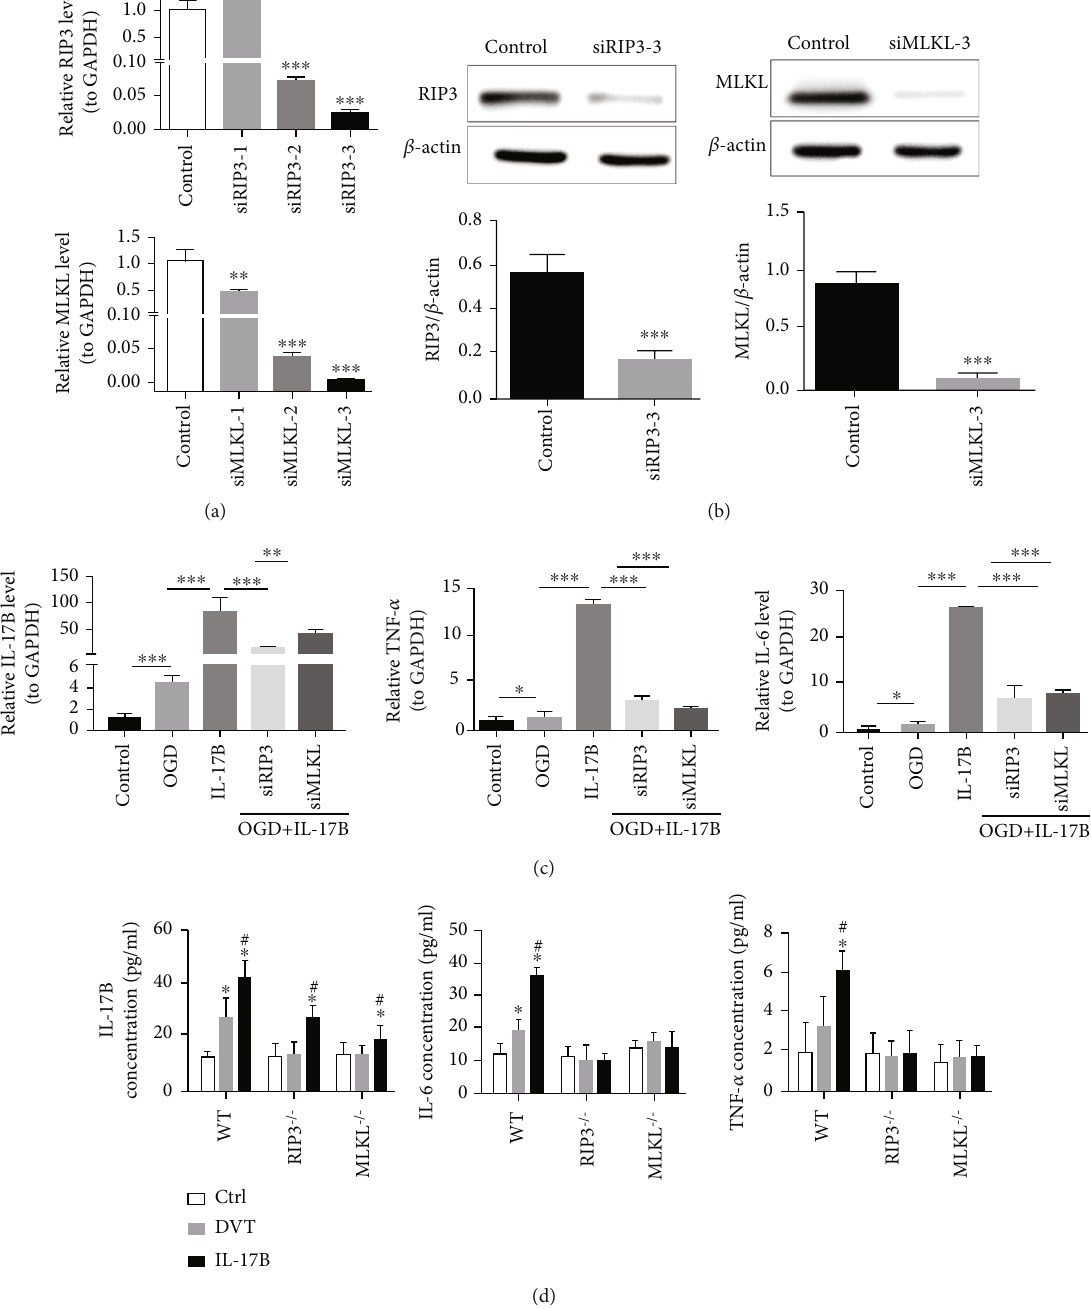
Figure 6: Il-17B promotes the expression of in fl ammatory factors mainly through the RIP3/MLKL pathway. (a) qRT-PCR was used to detect the interference e ffi ciency of di ff erent siRIP3 and siMLKL. GAPDH was used as an internal reference. (b)Western blot was used to detect the expression of RIP3 and MLKL protein in siRIP3, siMLKL, and normal cells, with β -actin as an internal reference. (c) The relative expression of IL-17B, IL-6, and TNF- α mRNA in each cell group were detected by qRT-PCR. GAPDH was used as an internal reference. (d) ELISA was used to test the plasma, TNF- α , and IL-6 in each mice group. Six mice were tested in each group. ANOVA was used for statistical analysis. ∗ P < 0 : 05 , ∗∗ P < 0 : 01 , and ∗∗∗ P < 0 : 001